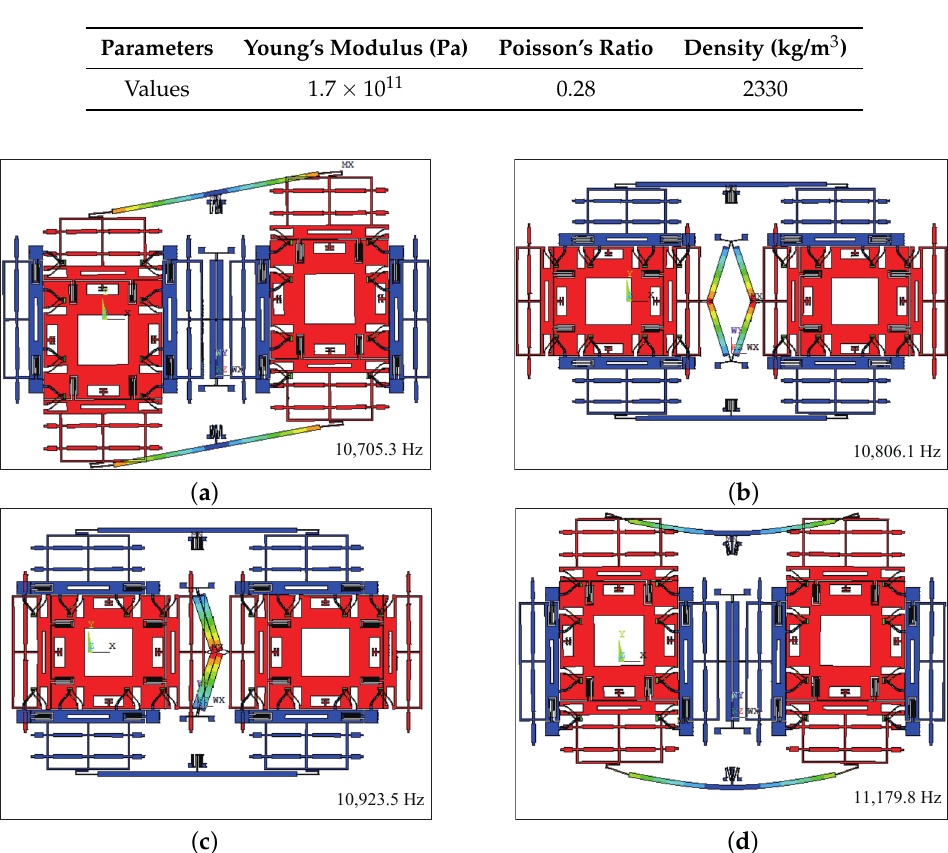
Table 2. Material parameters for FE simulations.